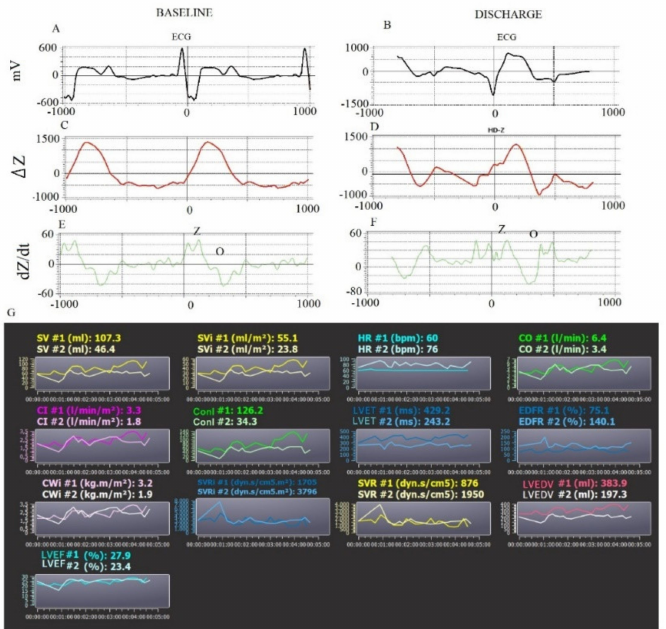
Figure 3. Example of 5 min noninvasive hemodynamic recordings at baseline and at discharge in HFrEF patients. ECG signals ( A , B ). Calibration Average Signals ( C , D ). Impedance Signals ( E , F ). Measured hemodynamic variables at baseline (#1) and at discharge (#2) ( G ). SV: stroke volume;